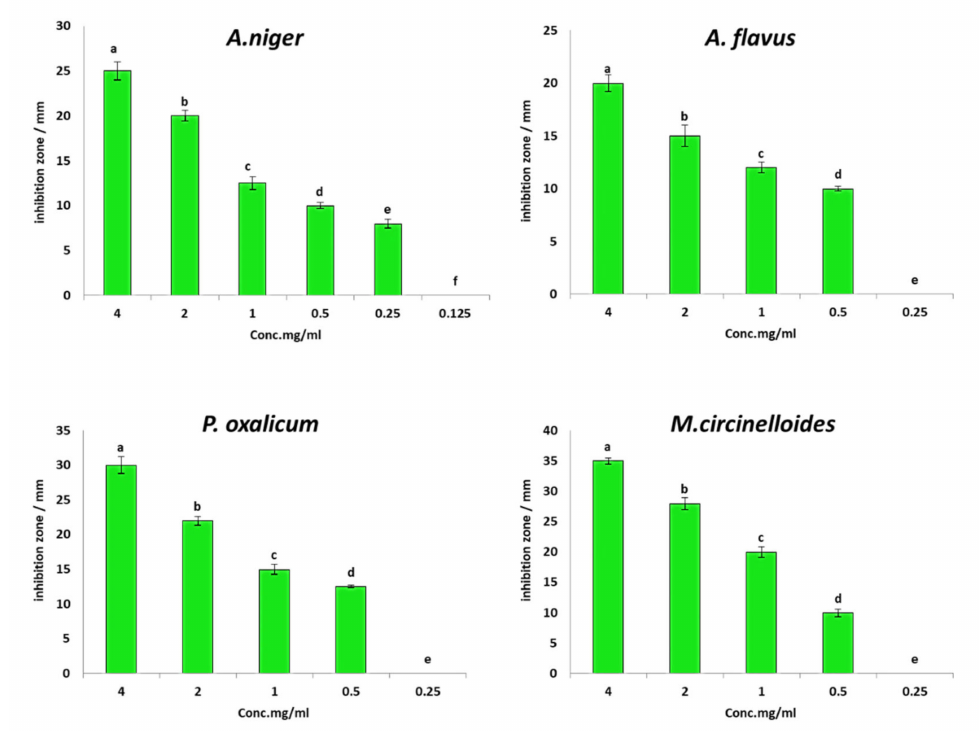
Figure 3. Minimum inhibitory concentrations of the four fungal extracts against F. oxysporum